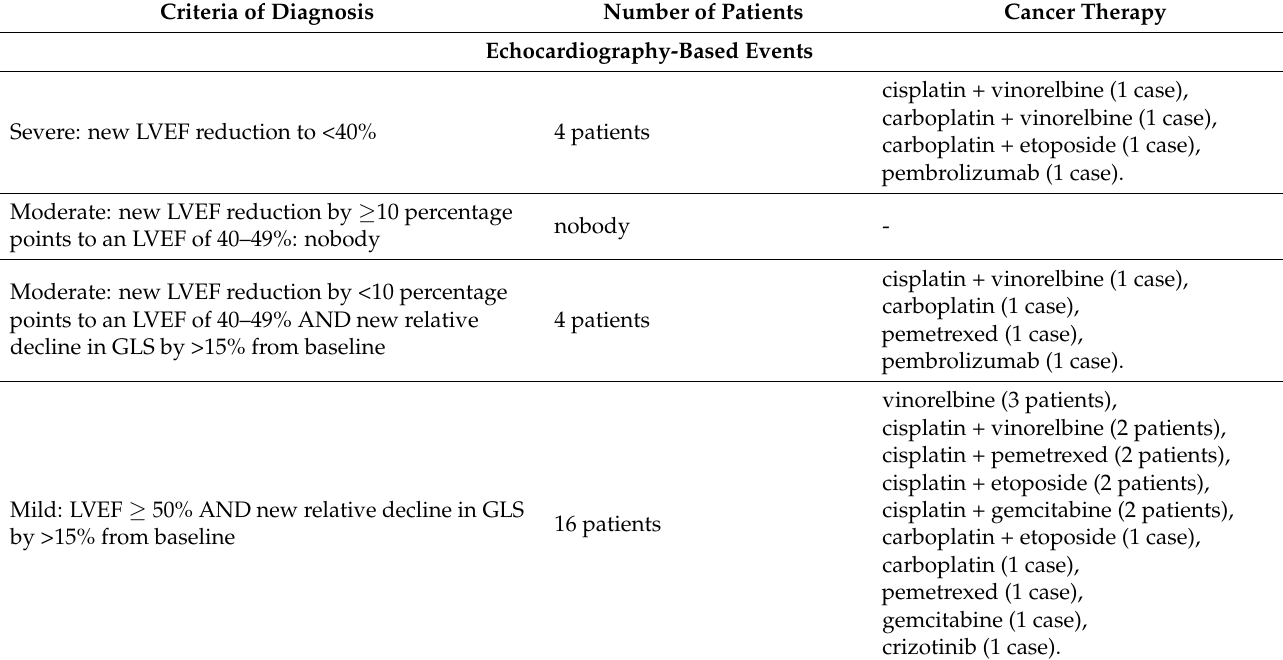
Table 2. Cardiovascular toxicities of lung cancer therapies diagnosed in accordance with the In- ternational Cardio-Oncology Society 2021 consensus statement [26].